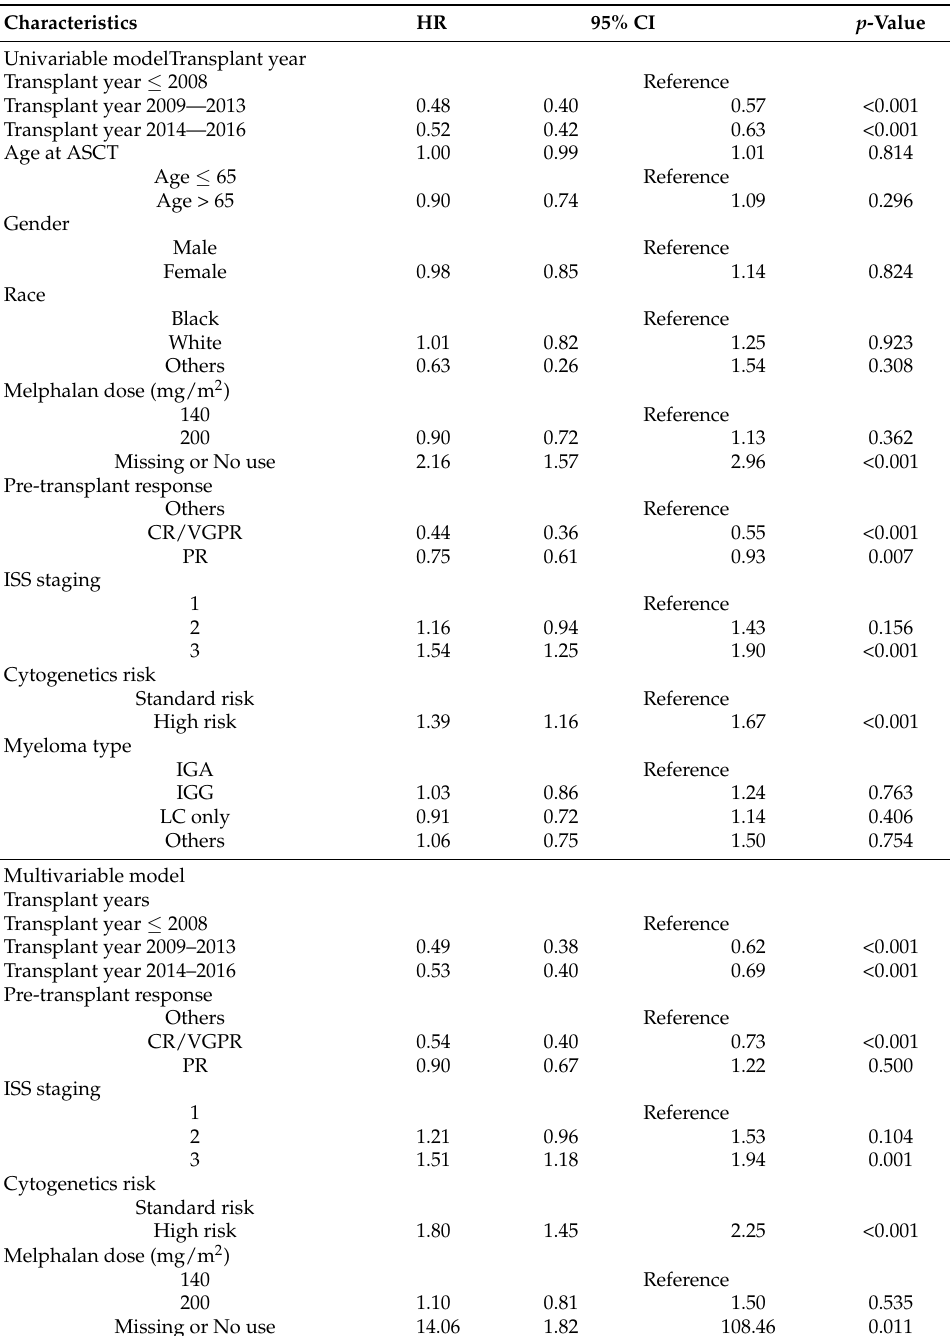
Table 2. Cox Proportional Hazard Model on Risk of Relapse or